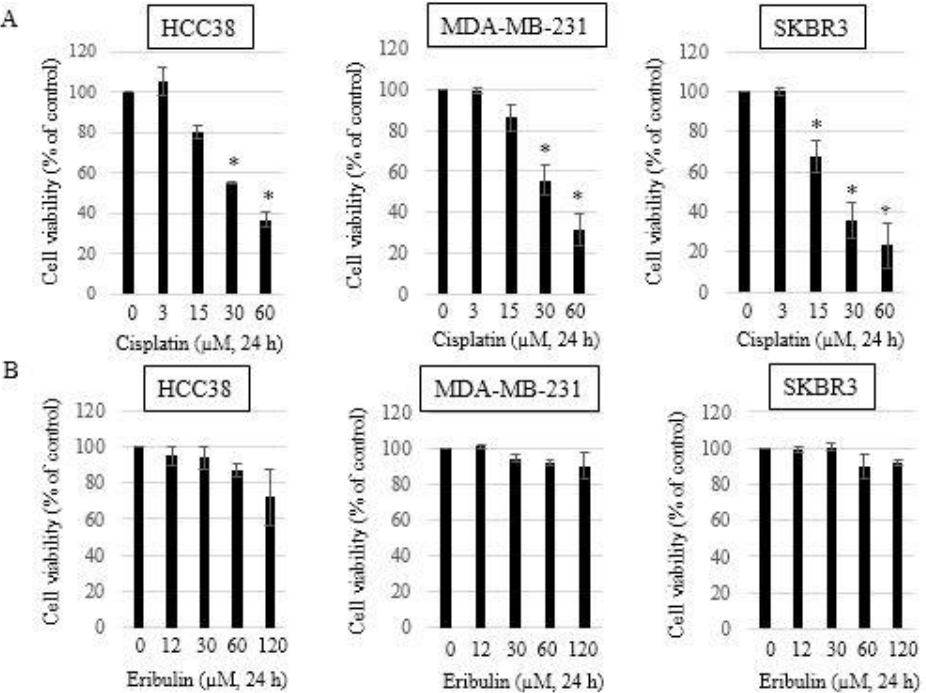
Figure 1. Effect of cisplatin and eribulin on the viability of HCC38, MDA-MB-231, and SKBR3 breast cancer cells. Cells were treated with cisplatin (3, 15, 30, and 60 µ M) ( A ) or eribulin (12, 30, 60, and 120 µ M) ( B ) for 24 h. Cell viability was measured using the Cell Counting Kit-8 assay. Each assay was performed in triplicate. Data are presented as the mean ± standard deviation; * p < 0.05 vs. untreated control.